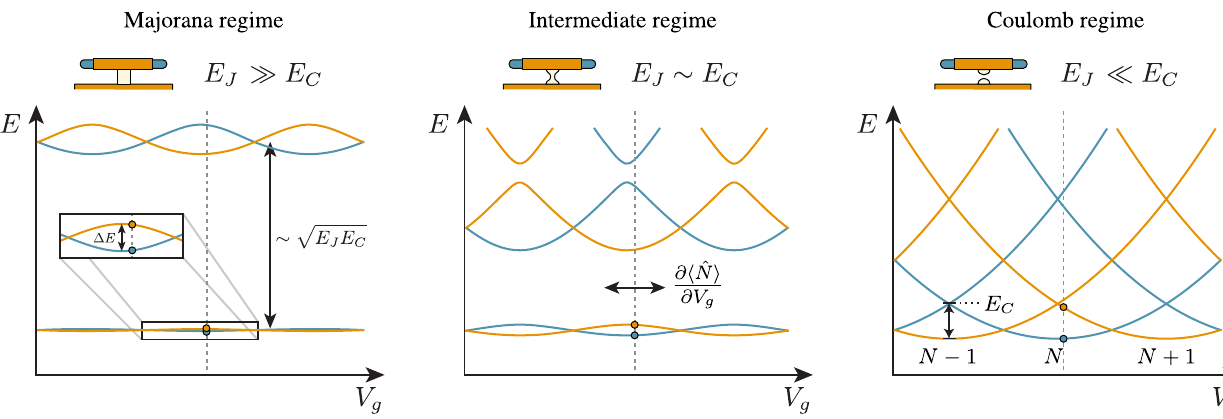
FIG. 15. Parity-to-charge conversion in the Majorana Cooper pair box, as described in Ref. [35], and energy levels of the Majorana ≫ E H =E Cooper pair box H as a function of gate voltage V and for different ratios E . In the Majorana regime E , charging C þ J g J C J C energy is negligible, and the spectrum is insensitive to V . The ground state is given by nearly degenerate states of opposite parity (blue g =E and orange), where the maximum separation Δ E vanishes exponentially in E , whereas the distance to the first excited states ffiffiffiffiffiffiffiffiffiffiffi J C p E E increases with is decreased by decreasing the coupling to the bulk superconductor, the ground-state degeneracy is lifted . As E J C J in the intermediate regime. Here, varying the gate voltage distinguishes the parity states through their differential capacitance ≪ E C ¼ ∂ h ˆ N i = ∂ V , which is larger for the orange parity than for the blue parity. Finally, in the Coulomb regime E , the spectrum is g J C given by parabolas with well-defined charge number N . If V is tuned to a minimum of a charge parabola, the two lowest-energy parity g states are separated by E , which can be used to impose a certain parity on the island. The intermediate regime can also be understood C from the emergence of avoided crossings between charge states of equal parity as E is J